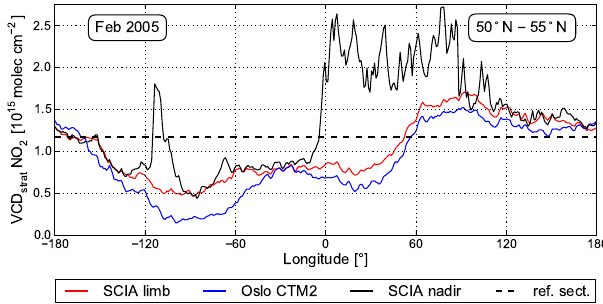
Fig. 11. Zonal variation of VCD 0 limb strat , VCD 0 mod strat , and VCD 0 nadir strat . The nadir measurements’ value over the reference sector is marked as dashed black line. Monthly mean values for February 2005, between 50 ◦ and 55 ◦ N.